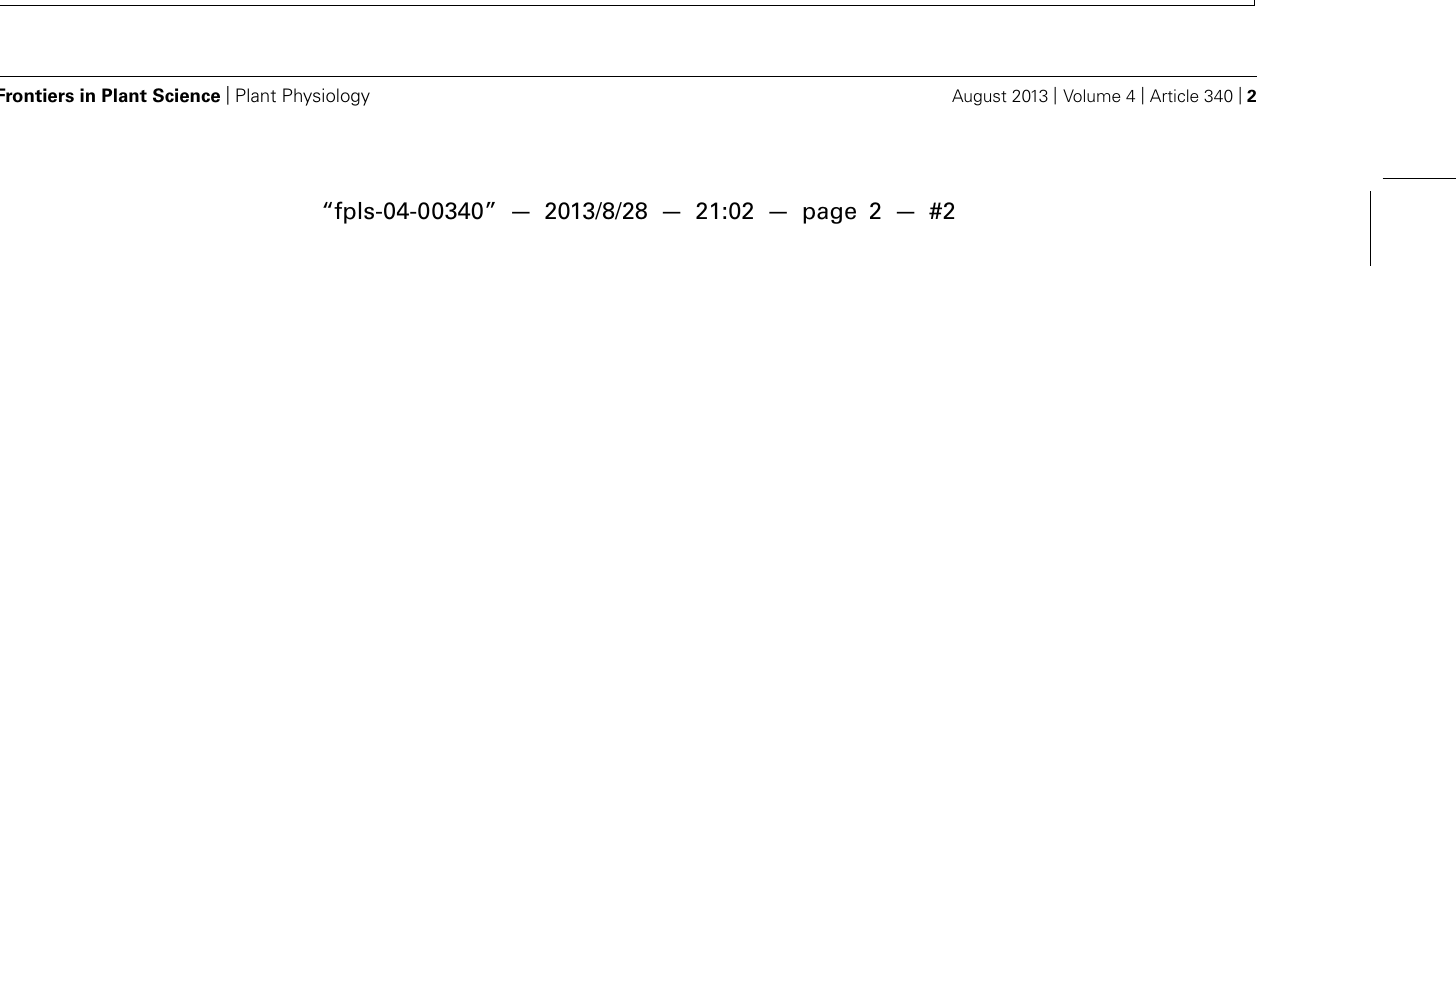
FIGURE 1 | Molecular structures and room temperature EPR spectra. (A) 100 μ M cPTIO(NNO); (B) 100 μ M cPTIO(INO), in